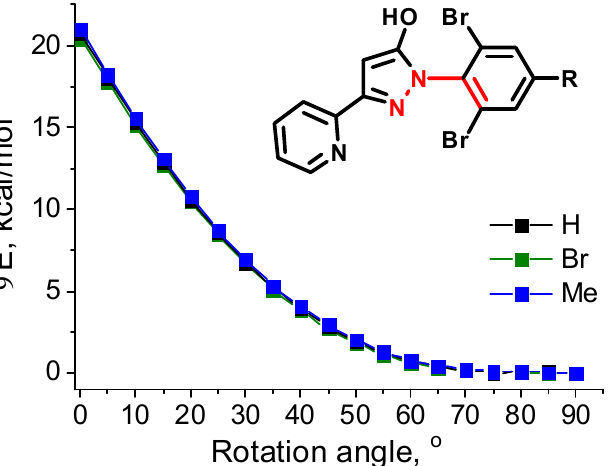
Figure 8. Energy variation upon the rotation of 2,6-disubstituted N-phenyl group relative to the pyrazol-3-yl plane as quantified by an angle between their least-square planes in model arylpyrazole pyridines according to TPSSh/def2-TZVP calculations.